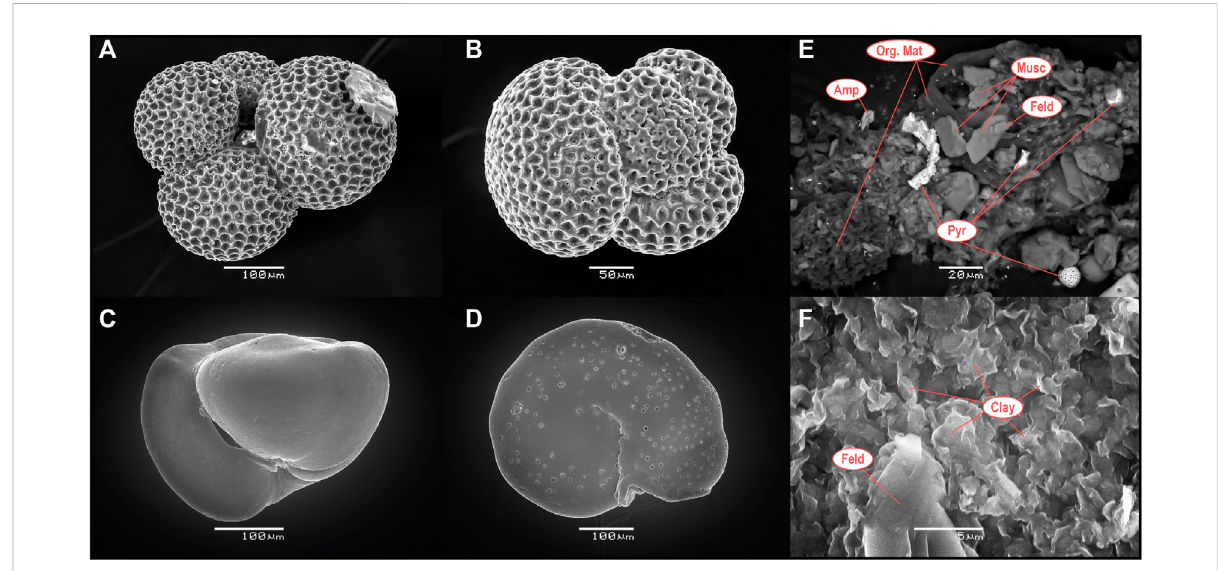
FIGURE 3 Back-scattered electron (BSE) SEM microphotographs of (A,B) planktonic foraminifera ( Subbotina sp. ) and (C,D) benthic foraminifera ( Gyroidinoides sp. and Cibicidoides sp. , respectively) from the DSDP Site 277. (E) and (F) are examples of residues remaining after 0.5 M CH 3 COOH tests dissolution. Abbreviations stand for Pyr, pyrite; Org. Mat, organic matter; Musc, muscovite; Amp, amphibole; Feld,